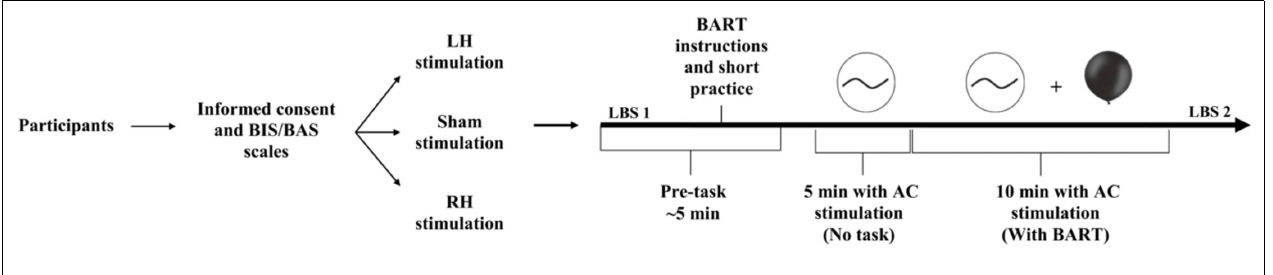
peak-to-peak intensity in the active stimulation conditions.The stimulation started 5min before the task began and was delivered during the entire course of the BART, which lasted < 10min. Before and after stimulation and the BART participants performed the line-bisection